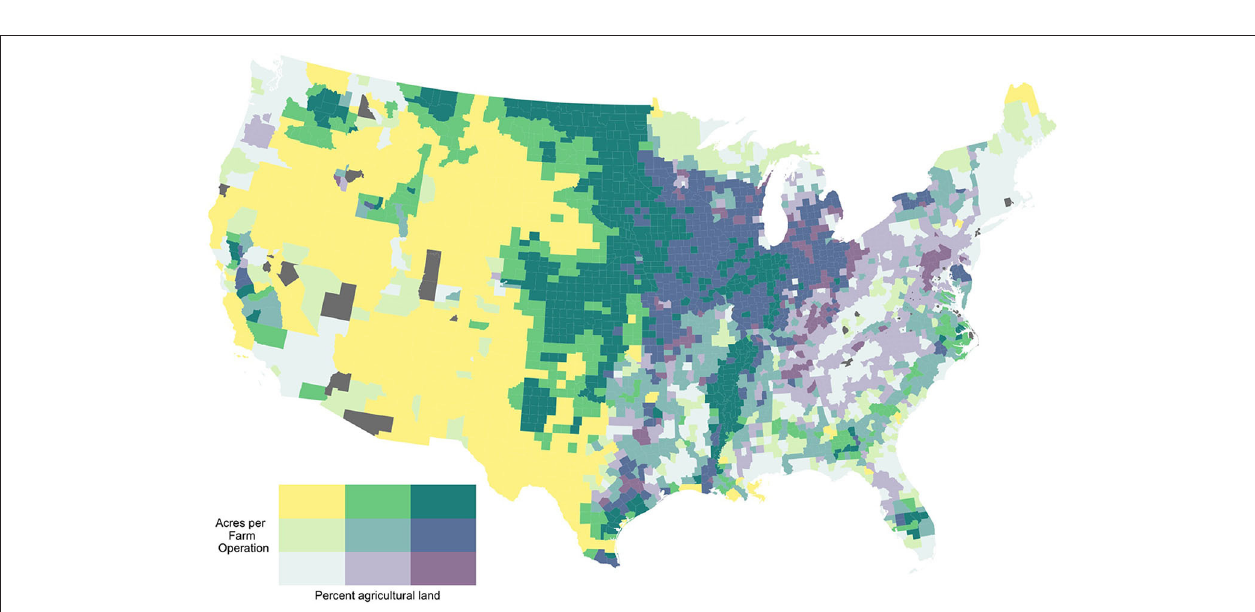
FIGURE 6 | Average farm size (acres per operation) by county in 2012. Data: USDA NASS Census of Agriculture.